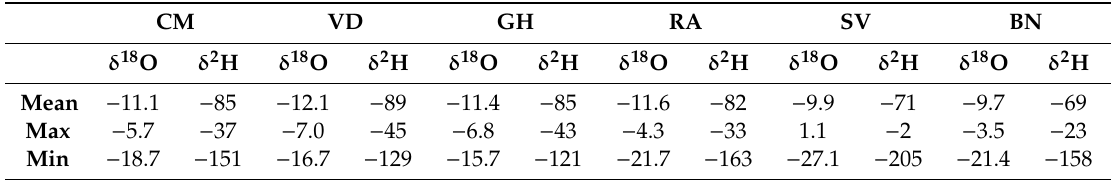
Figure 3. The stable isotope composition of precipitation water from SV (circle), BN (square) and RA (triangle) for winter (blue) spring (green), summer (red) and autumn (orange). The mean values for each season are represent by rhomb with black contour marks for river water, and with rhomb with black full marks for precipitation. The dotted black line represents the GMWL (Global Meteoric Water Line) and the dotted gray line represents local meteoric water line (LMWL). Table 2. The mean, maximum (max), and minimum (min) δ 18 O and δ 2 H values in precipitation water at C â mpulung Moldovenesc (GM), Vatra Dornei (VD), Gura Haiti (GH), Rar ă u (RA), Suceava (SV) and Bistri¸ta-N ă s ă ud (BN) stations.